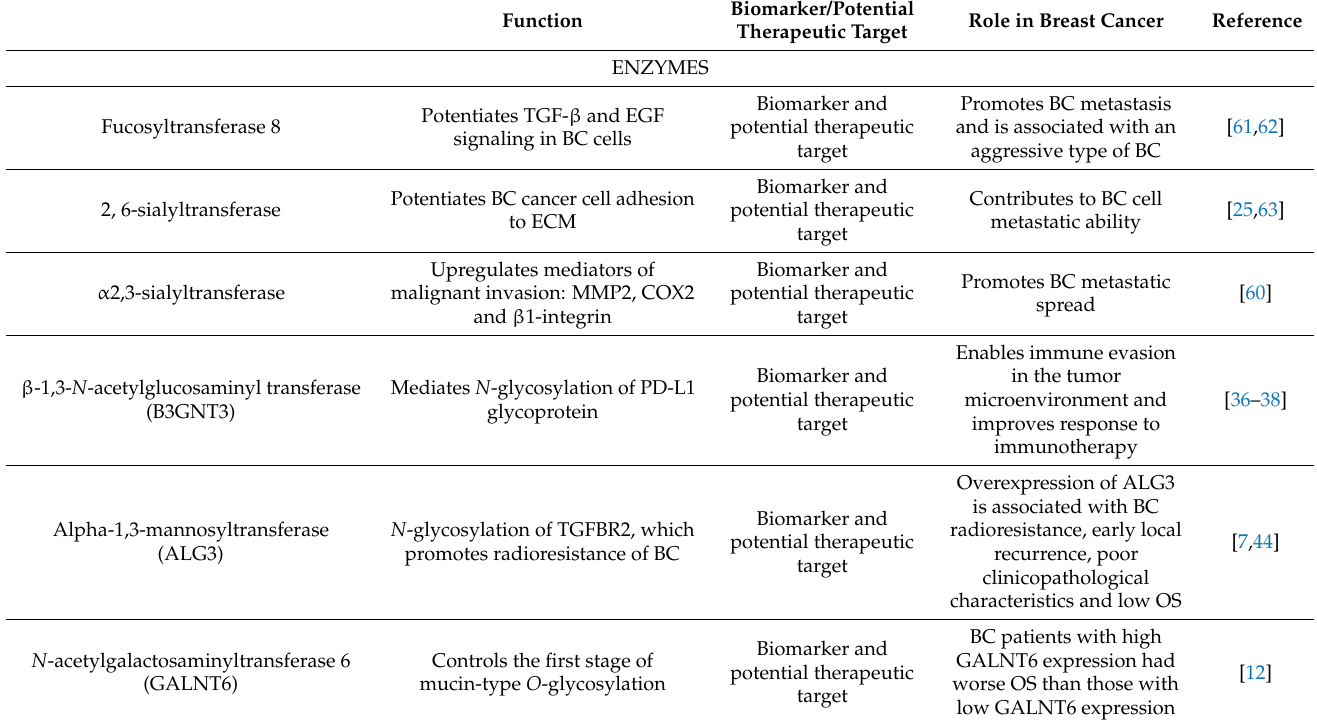
Table 1. Glycosylation enzymes, glycans and other glycoconjugates involved in breast cancer progression—potential biomarkers and treatment